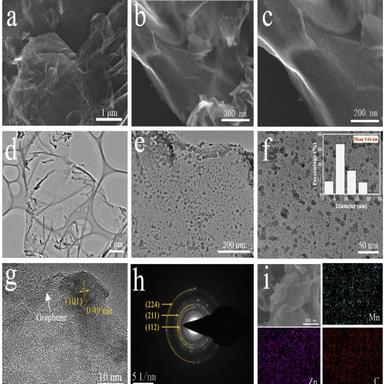
(a–c) SEM images, (d–f) TEM images, (g) HRTEM image, (h) SAED pattern, (i) SEM image and corresponding EDX elemental mapping of the ZnMn2O4 NDs/ rGO composite. Inset of (f) is the size distribution of the ZnMn2O4 nanodots.